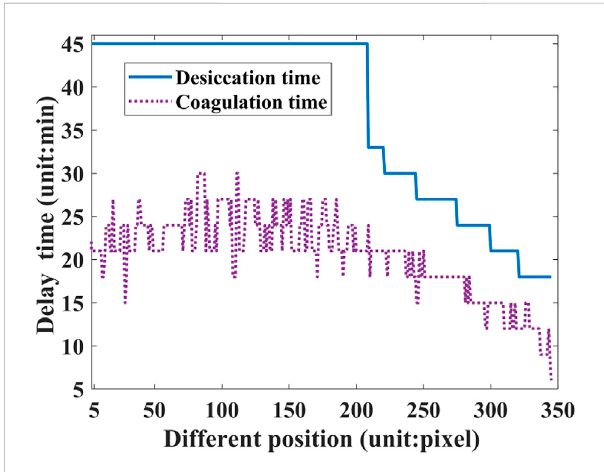
FIGURE 11 Pixel-wise desiccation time and coagulation reaction